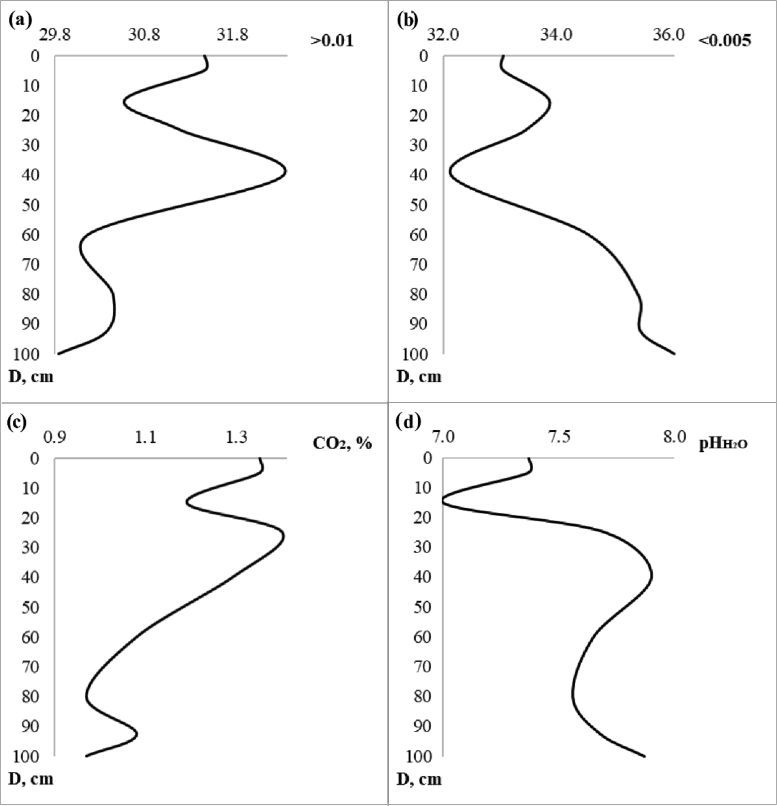
Distribution by profile of pedosediments of the main physico-chemical parameters (2013).